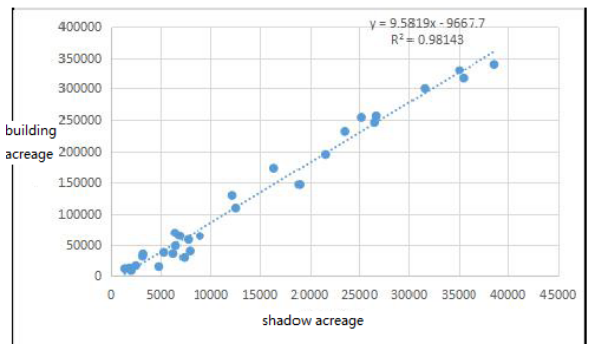
Figure 1 regression analysis of the total building acreage and shadow